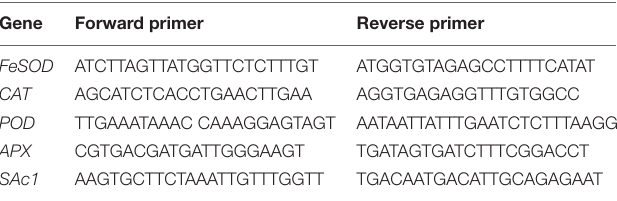
TABLE 1 | Sequence of forward and reverse primers used in gene expression